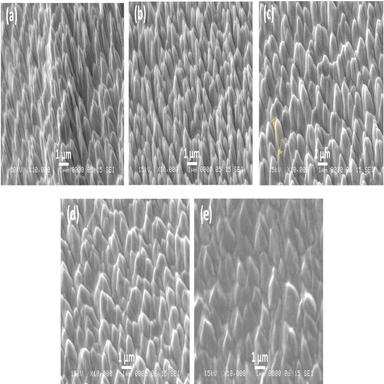
(a-e) The surface morphology (SEM images) of AuNPs at 5 typical regions, 1 ~ 5, respectively. The arrow in (c) is an example of the measured slant height.